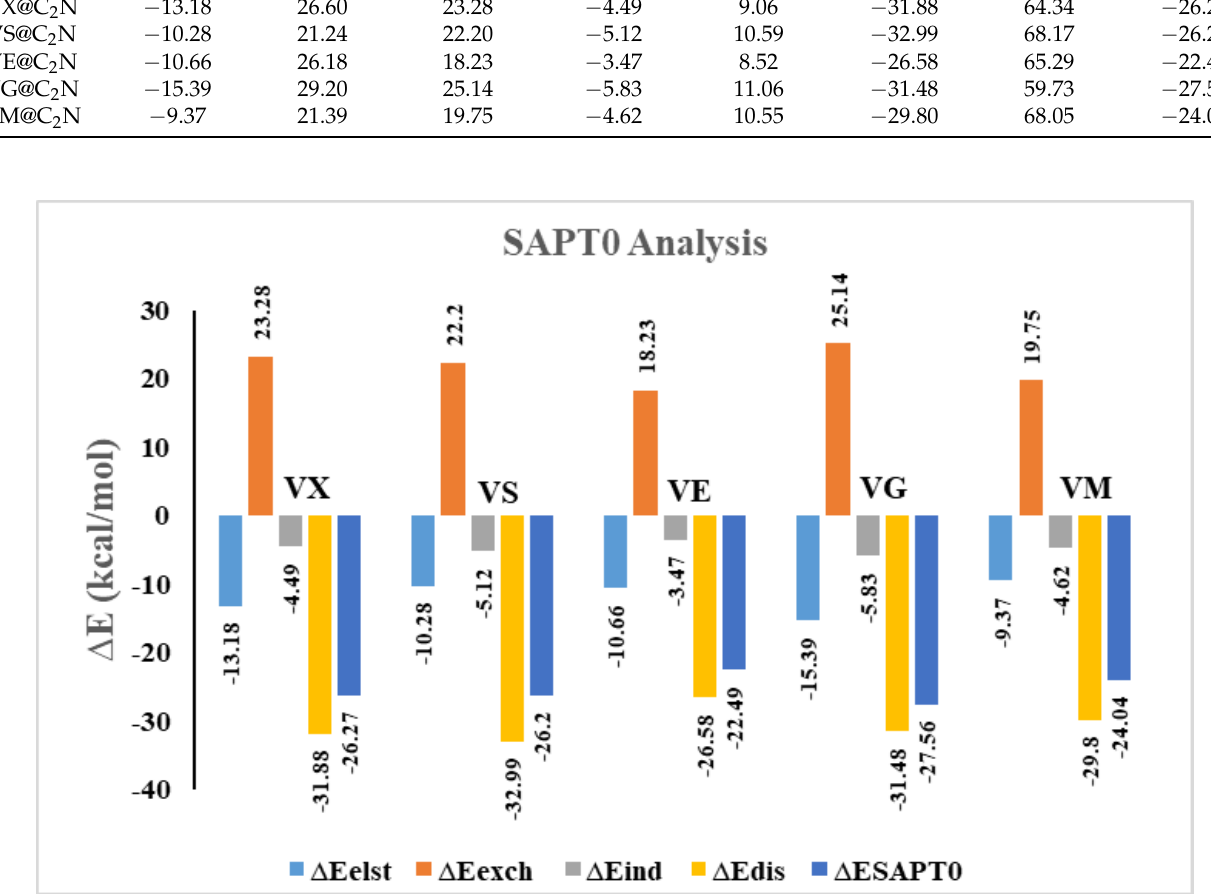
Figure 7. SAPT0 analysis of V-series@C 2 N complexes graphical representation. Table 3. SAPT0 analysis of V-series@C 2 N complexes (kcal/mol).